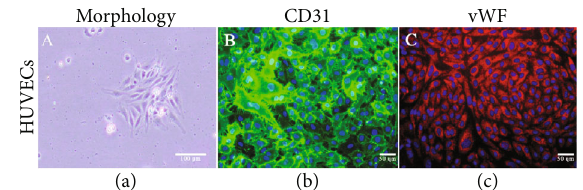
Figure 1: Growth colony and the expression of endothelial cell markers of isolated HUVECs. A typical cobblestone-like colony was observed after 24 hours culture (a). A representative image of (b) CD31 (green) and (c) vWF (red) was detected in HUVECs regardless of their cultivated condition. Nuclei of the cells were indicated by 4 ′ ,6-diamidino-2-phenylindole staining. Studies were performed on three independent cell lines with duplicates. Scale bar: 100 μ m (a) and 50 μ m (b,